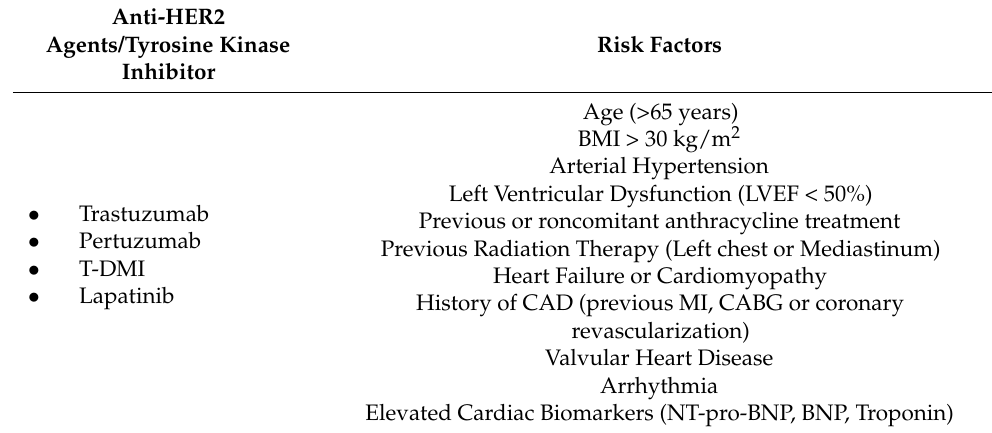
Table 3. Risk factors for anti-HER2-induced cardiotoxicity